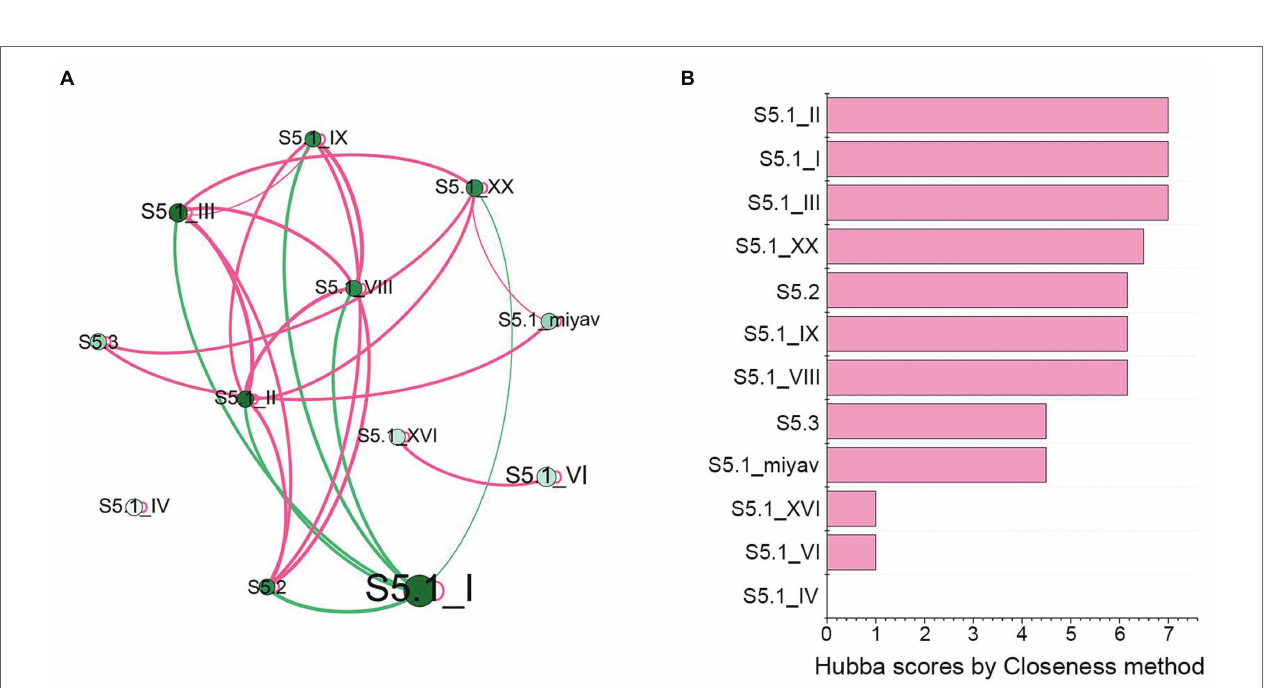
FIGURE 3 | Genomic composition of Synechococcus assemblages. (A) The maximum-likelihood (ML) tree constructed using rpo C1 sequences with relative abundances of more than 0.1%. (B) The relative abundance of Synechococcus clades.